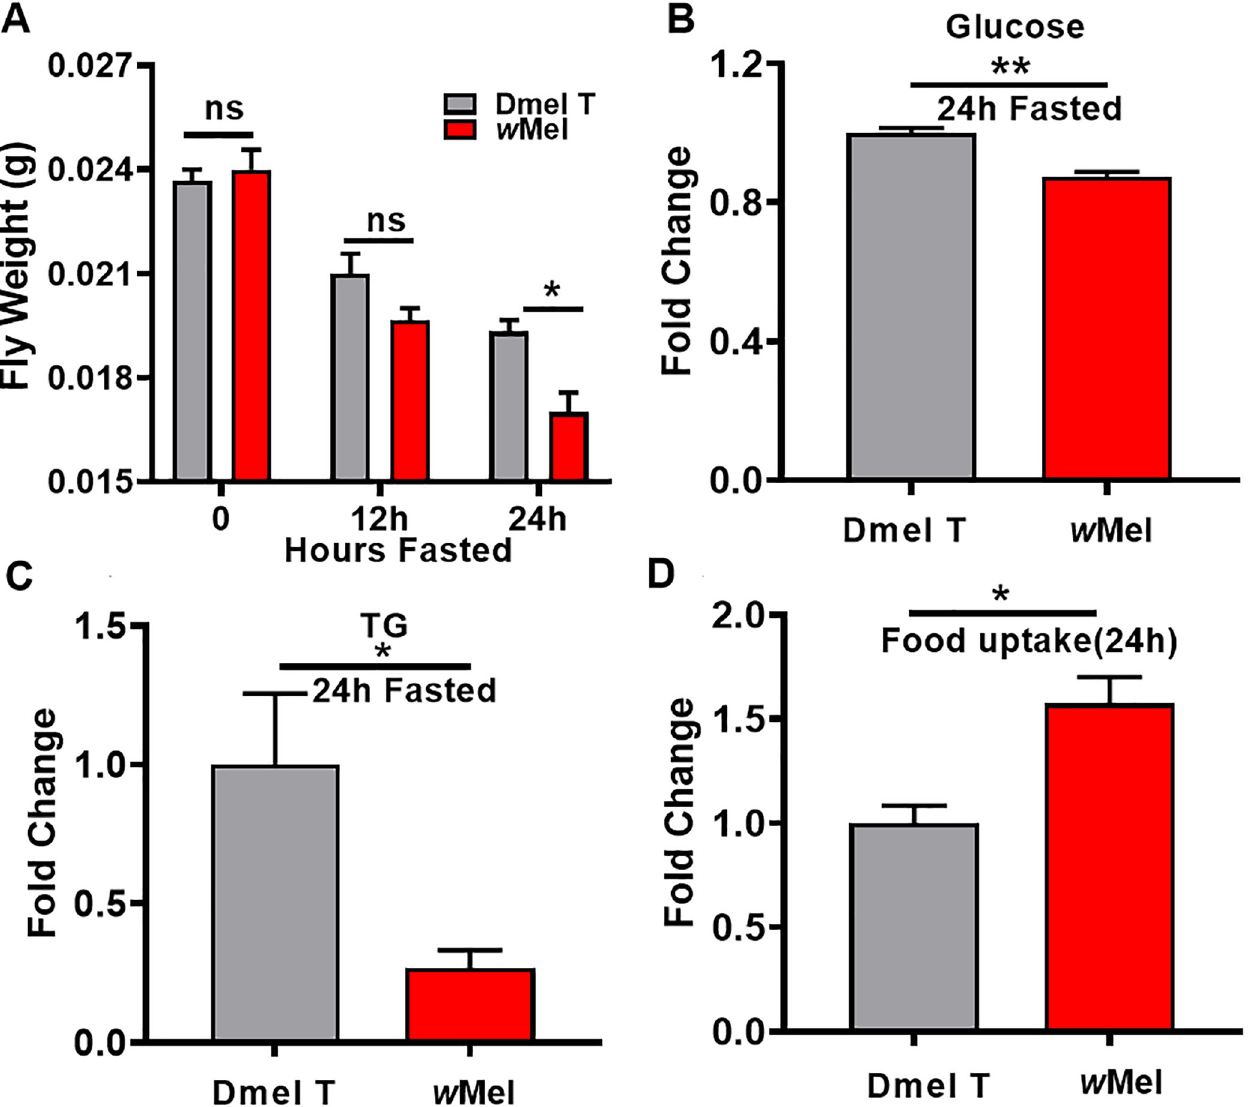
Fig 7. Wolbachia infection promoted the energy consumption and food intake in D . melanogaster . (A) The body weight of 30 male flies with fasting food and water at the three time points. (B) The fold change of D-glucose in Dmel T and w Mel flies after 24h fasted. (C) The fold change of triglycerides (TGs) in Dmel T and w Mel flies after 24h fasted. (D) The fold change of food uptake in Dmel T and w Mel flies during 24 h after eclosion. Dmel T: uninfected flies; w Mel: Wolbachia -infected flies. � P < 0.05; �� P < 0.01. ns: not significant.